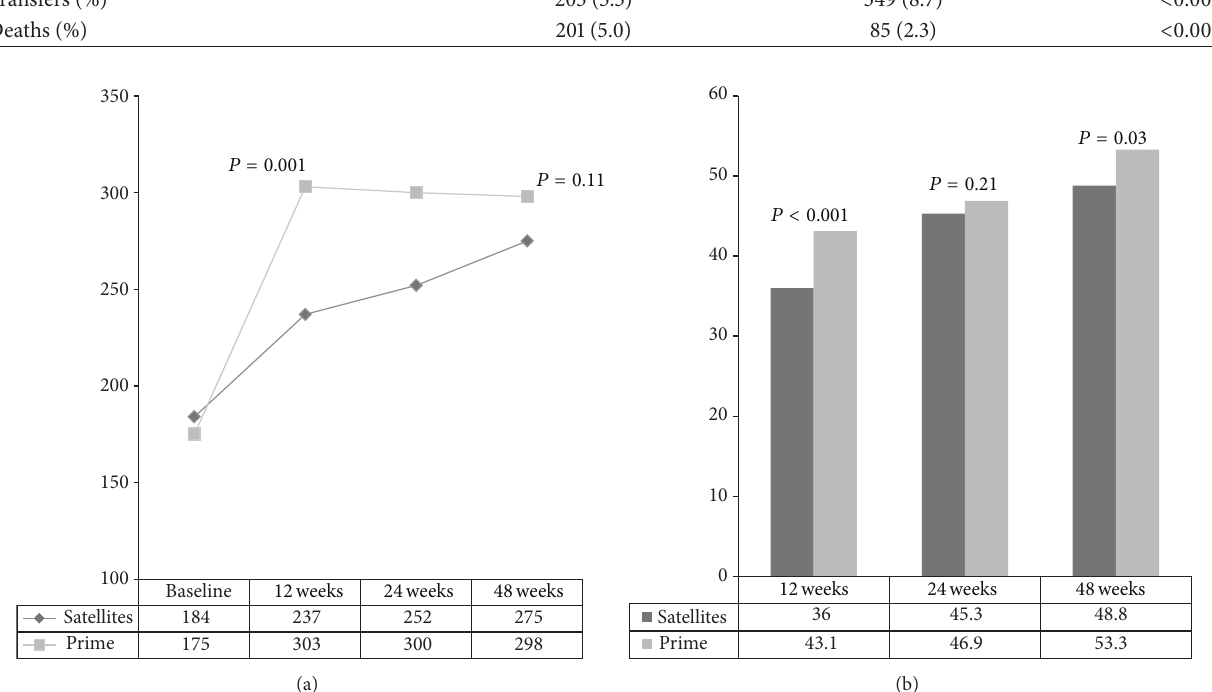
Figure 3: (a) Line graph showing trend in median CD4 levels (cells/mm 3 ) at baseline through 48 weeks of follow-up between patients at the prime and satellite sites in Jos, Nigeria. (b) Bar chart showing proportions of patients achieving undetectable viral load ( < 400copies/mL) from 12 through 48 weeks of follow-up in patients at the prime and satellite sites in Jos,